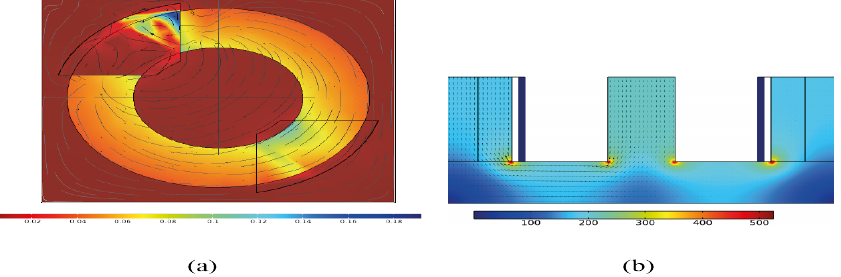
Figure 6. Examples of magnetic flux density simulations’ in Comsol Multiphysics for a powder core with shape: ( a ) toroidal , and ( b ) “E”.